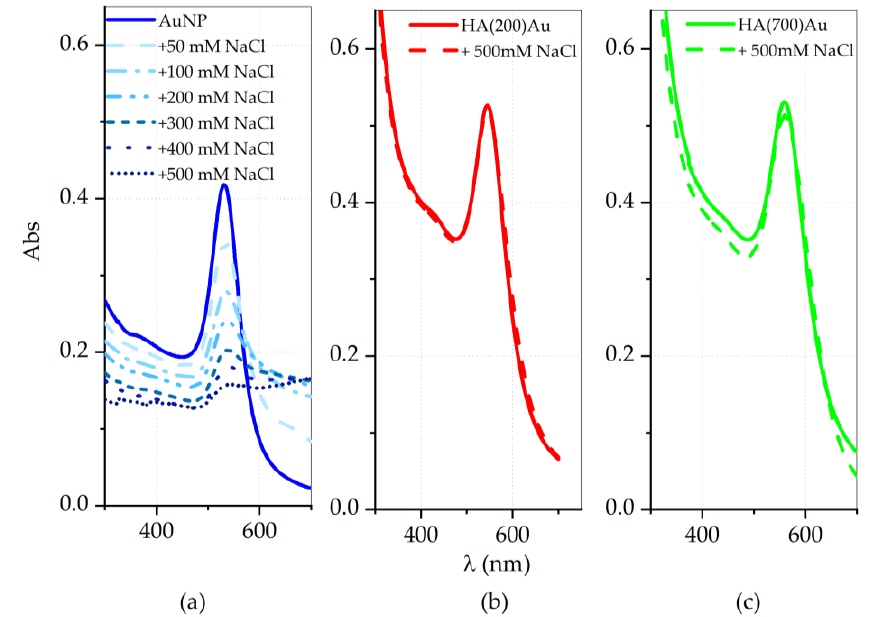
Figure 5. UV-visible spectra of bare AuNP ( a ) before (solid line) and after (dashed lines) the gradual addition of NaCl aqueous solution at increasing concentrations from 0.05 M to 0.5 M. The UV-visible spectra before (solid line) and after (dashed lines) the direct addition of 0.5 M NaCl are shown in ( b ) for HA(200)Au (0.11 nM = 4 × 10 3 AuNP/mL) and in ( c ) for HA(700)Au (0.06 nM = 6 × 10 2 AuNP/mL).